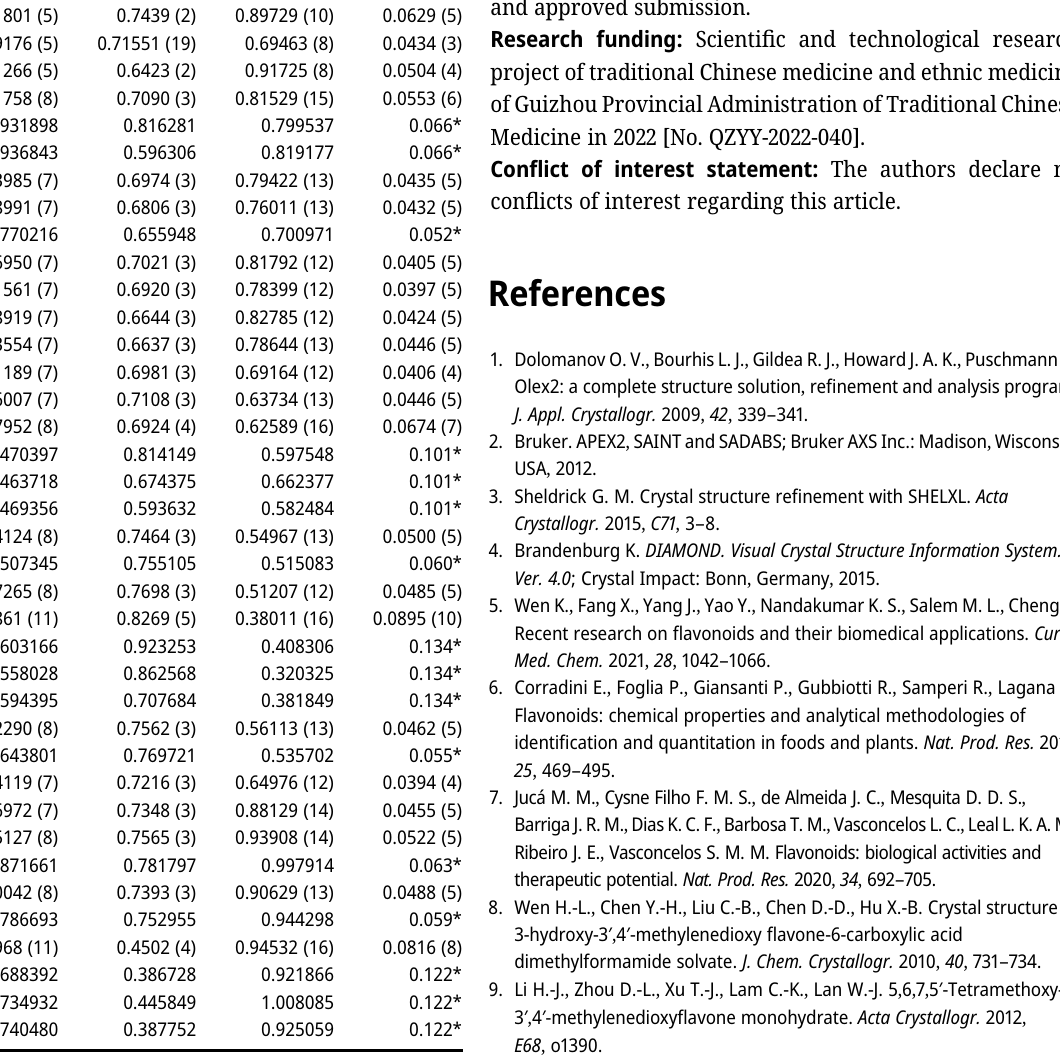
ketone bonds were determined at the distance of 1.227(2) Å Table  : Fractional atomic coordinates and isotropic or equivalent